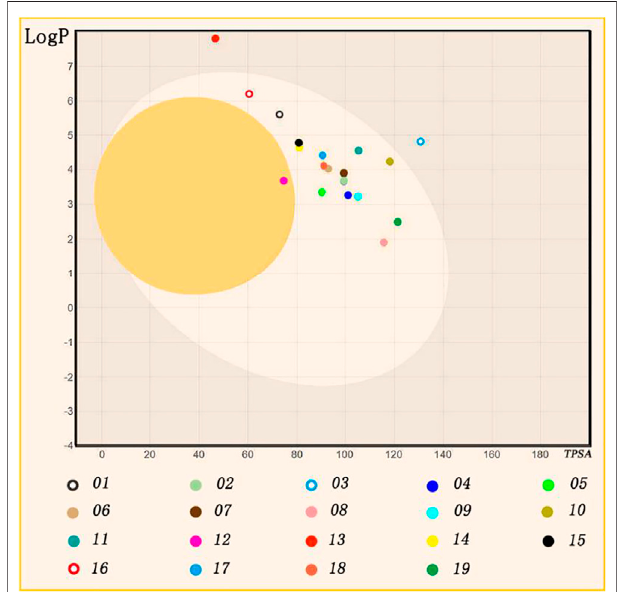
FIGURE6| ADMEevaluationresult.Differentcolorcirclesstandforeach